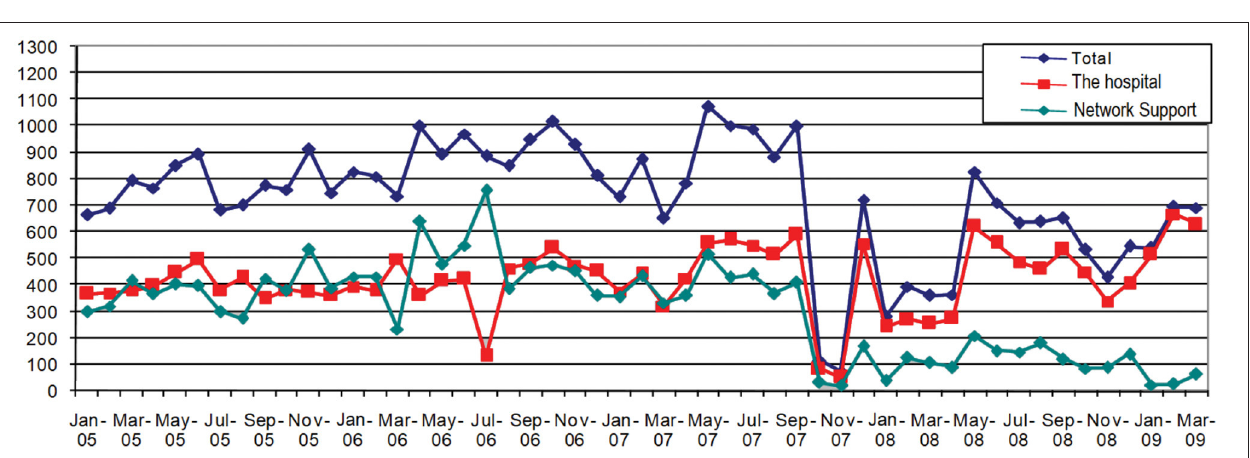
FIGURE 1 | Biopsies performed in the pathology department. Source: Anatomic Pathology